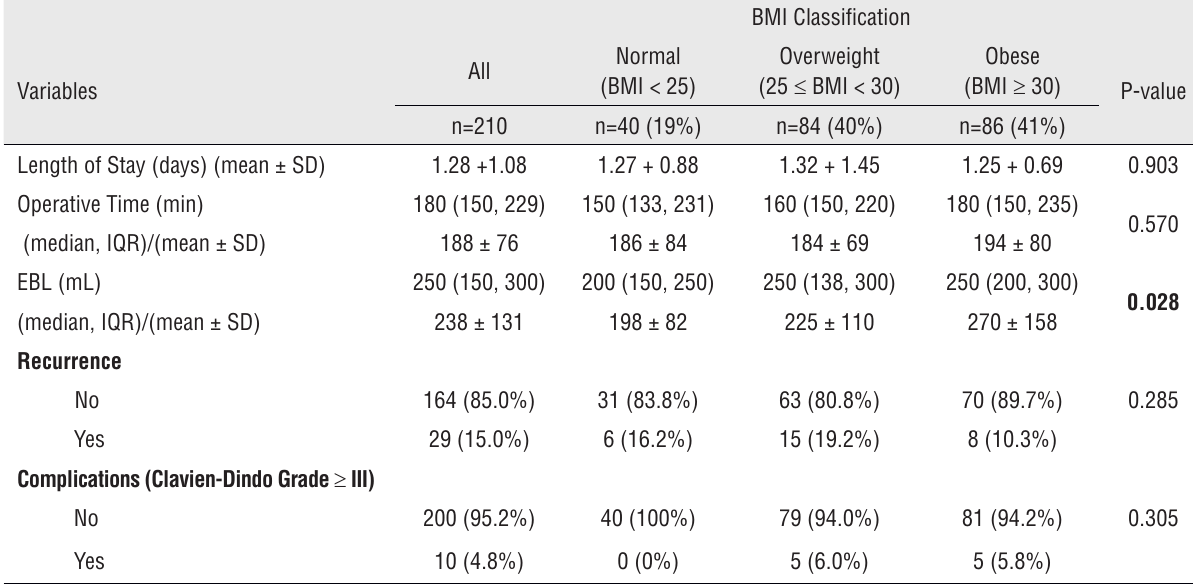
Table 2 - Patient outcomes by BMI